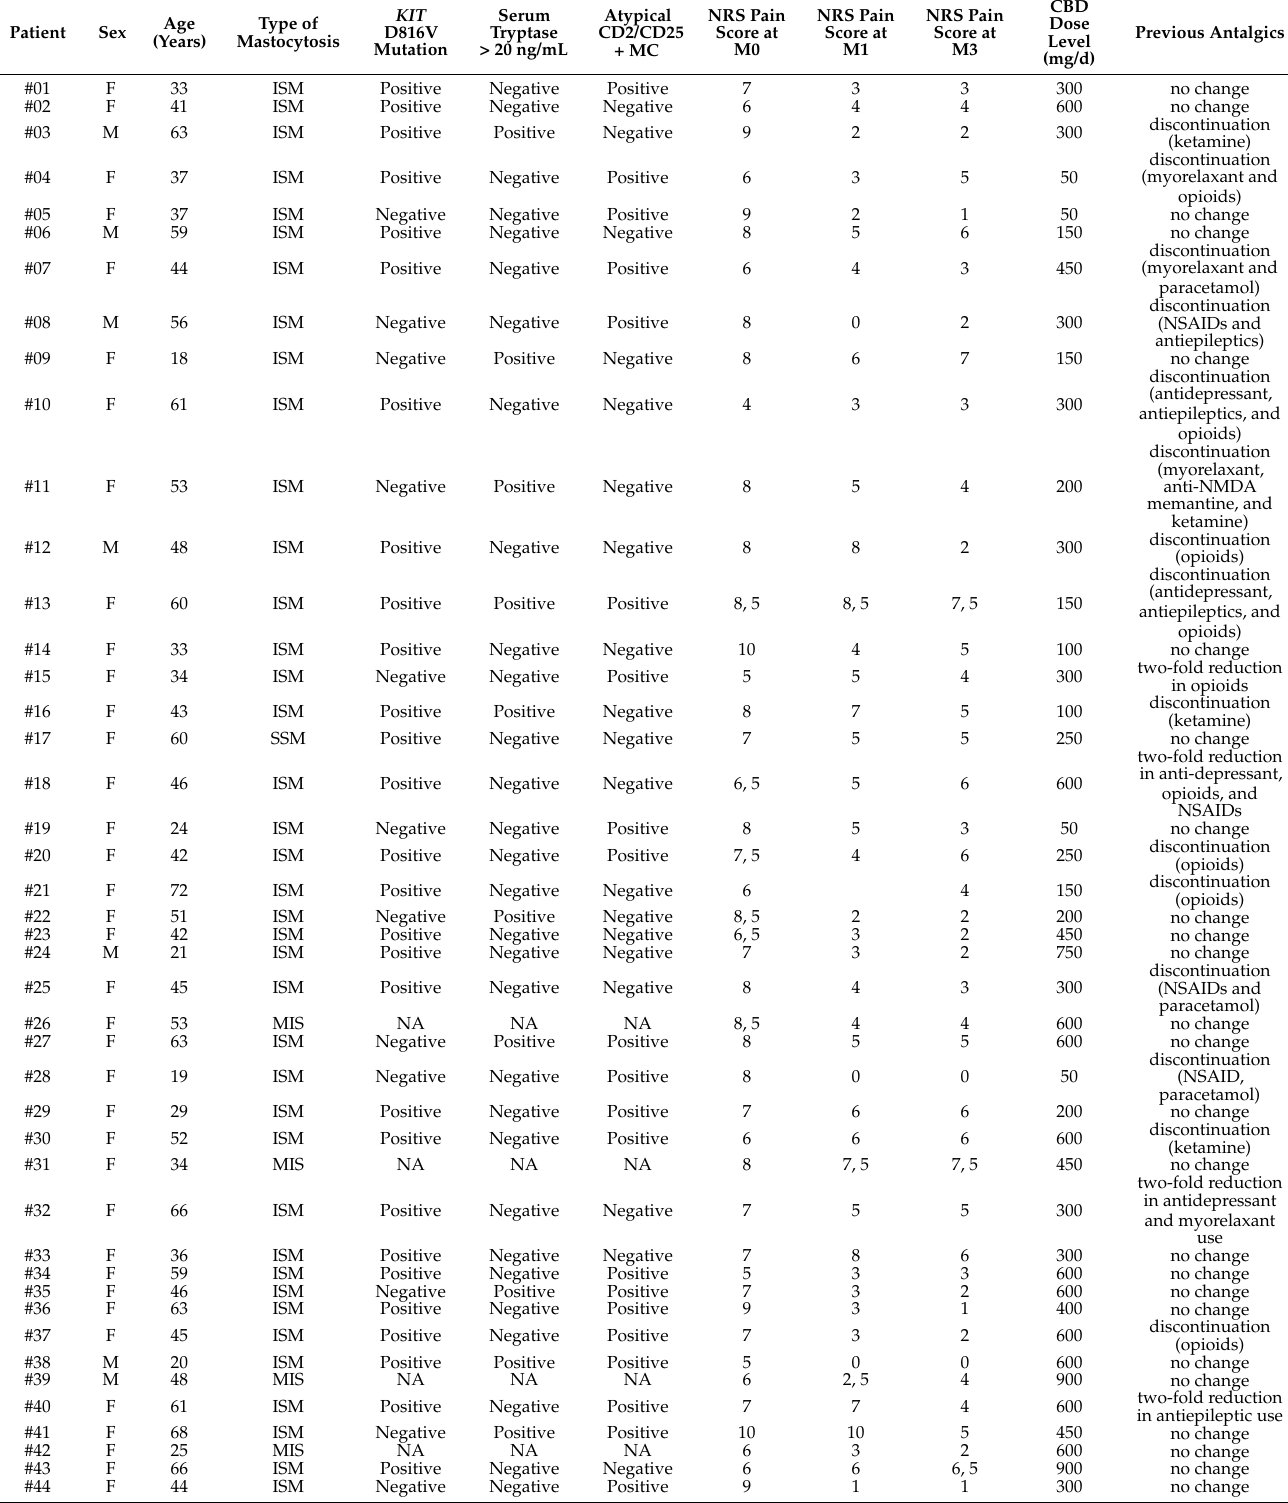
Table 1. Characteristics of the patients and the mastocytosis, the numerical rating scale pain scores, the CBD dose level, and changes in other drug